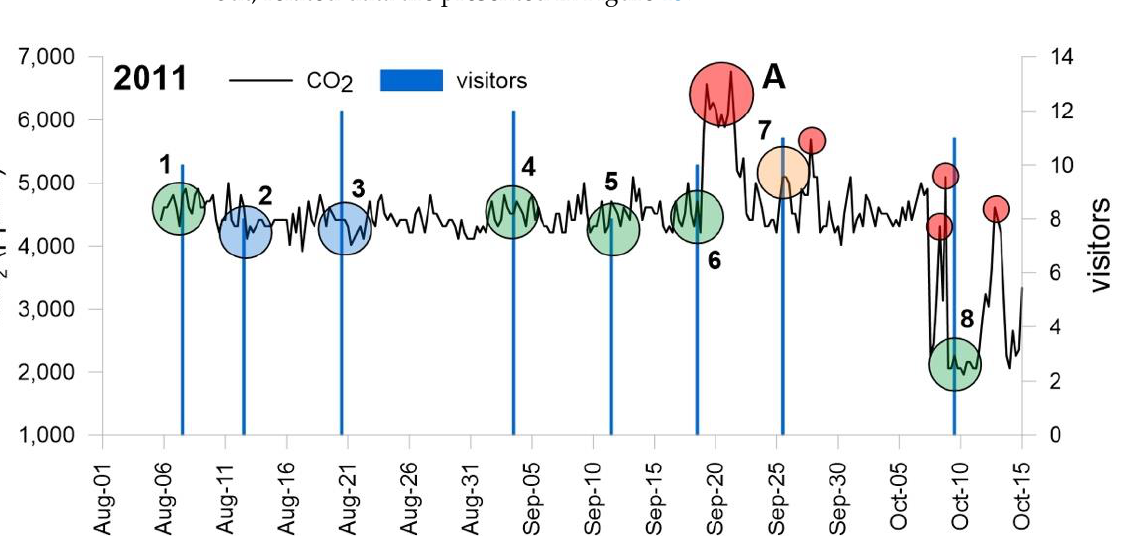
Figure 15. Near-real-time data (6 h) of air CO 2 concentration in the atmosphere of the Santa Ninfa cave (black line), compared to the visitor number (blue vertical bars). Green, blue and orange circles identify fruition events after which CO 2 did not variate, diminish, or increase, respectively. Red circles indicate CO 2 increments occurred independently of the presence of visitors.